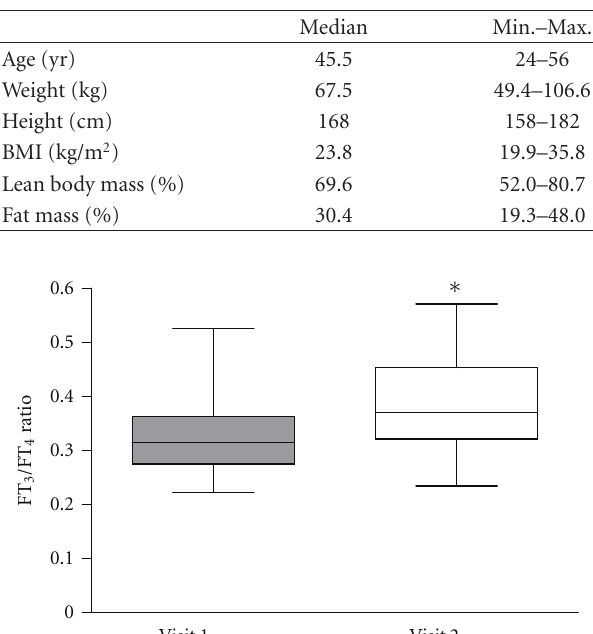
Table 1: Anthropometric characteristics of subjects ( n = 22; 19 females, 4 males).